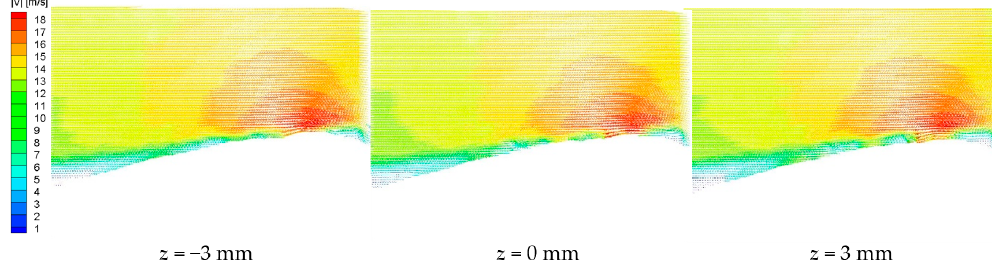
Fluids 2019 , 4 , x FOR PEER REVIEW Figure 9. Instantaneous vector field with turbulent separated region for dimpled airfoil (15-degree AoA).